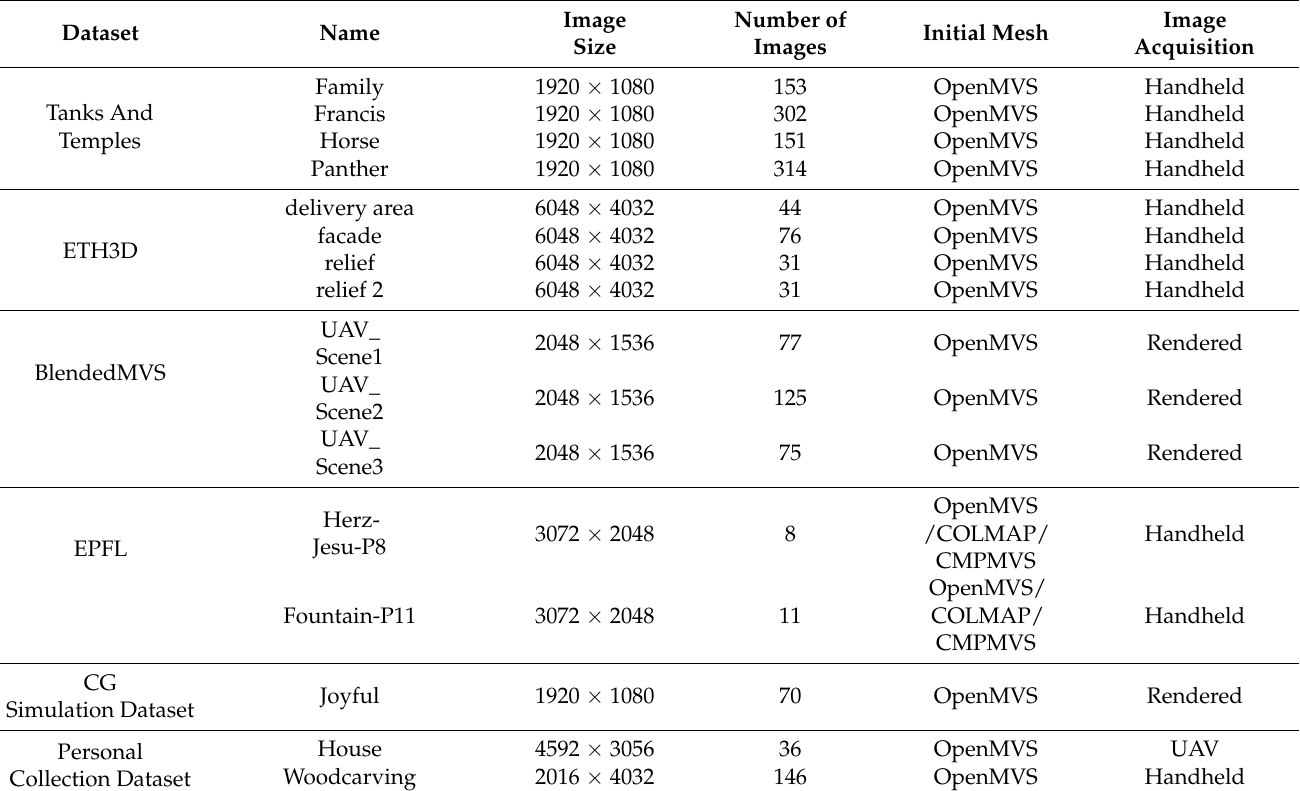
Table 1. Introduction to the datasets used in this